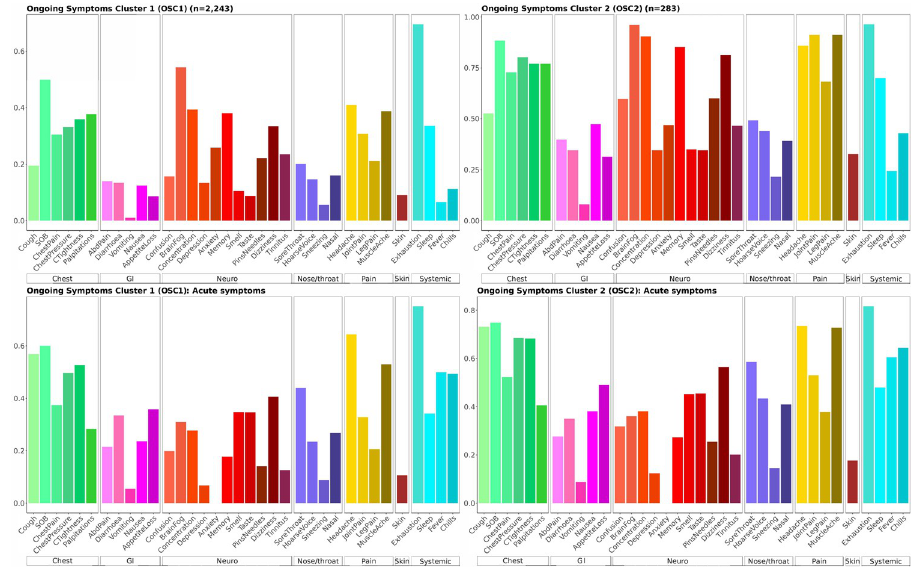
Fig 3. Two clusters of ongoing symptoms and acute symptoms among these